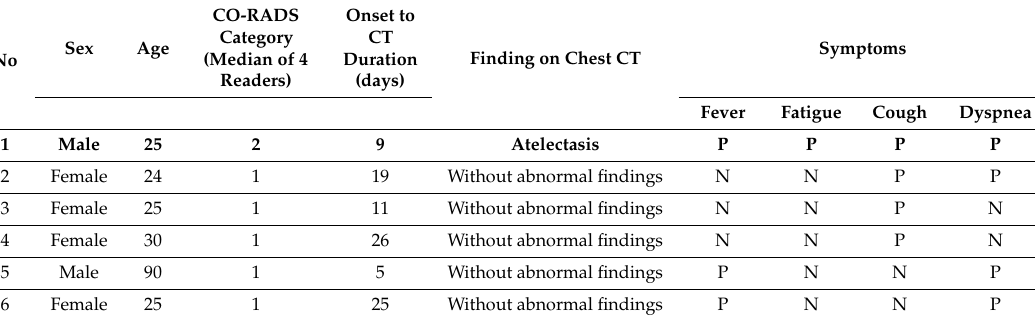
CO-RADS, COVID-19 Reporting and Data System; CT, computed tomography; P, positive; N,